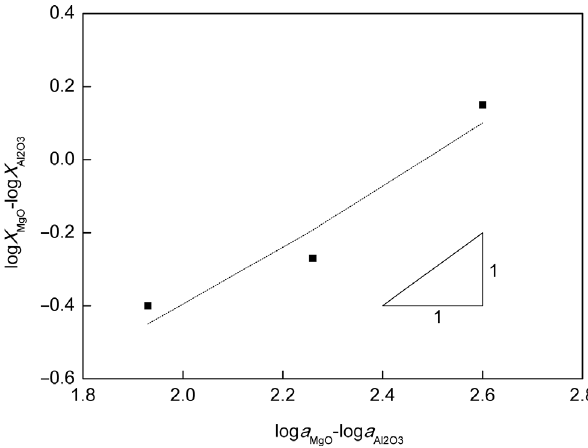
Figure 9 : Composition of inclusions, log ( X MgO / X Al2O3 ) as a function of log ( a MgO / a Al2O3 ) of slag at 1,873 K.